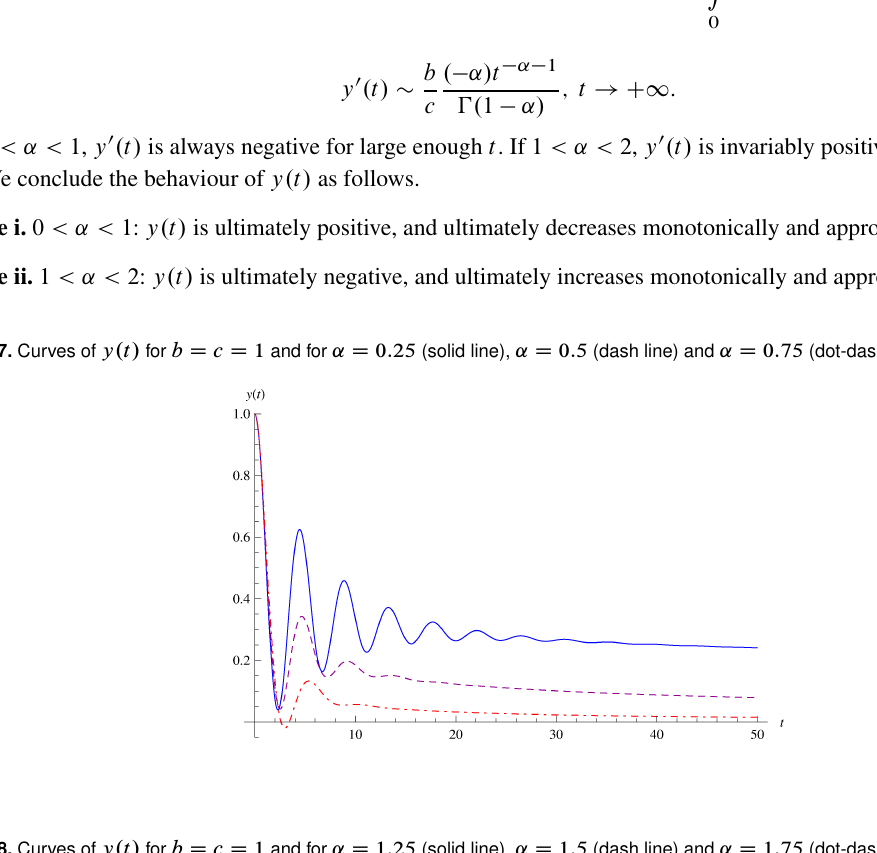
Fig. 8. Curves of y.t/ for b D c D 1 and for ˛ D 1:25 (solid line), ˛ D 1:5 (dash line) and ˛ D 1:75 (dot-dash